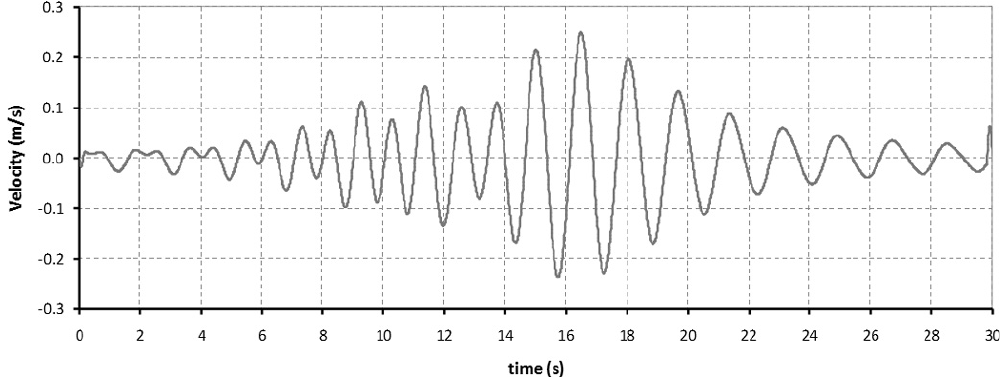
Fig. 3. Velocity of the wave paddle derived from the